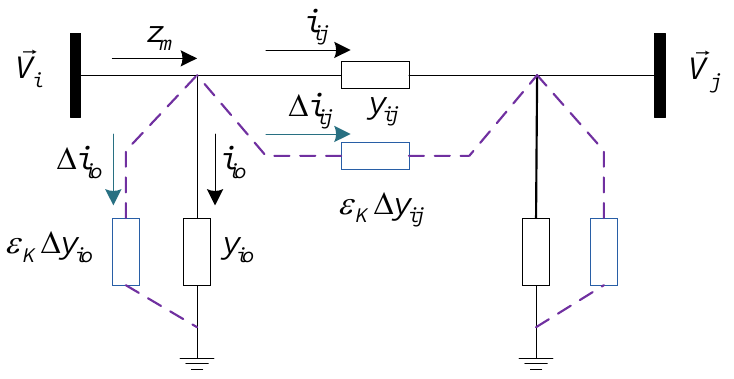
Figure 1. Equivalent circuit with adjustable admittances. In Figure 1, y ij and y io are constant admittances representing the nominal value, i ij and i io represent the currents following through y ij and y io , and ε K ∈ [ − 1, 1 ] refers to the adaptive parameters. According to the temperature variations, ∆ y ij and ∆ y io are safety allowance admittances approximated by the previous static data; ε K ∆ y ij and ε K ∆ y io are the adjusted terms; and ∆ i ij and ∆ i io represent the currents following through ε K ∆ y ij and ε K ∆ y io . Due to the transmission delay, ε K will be adaptive to be values within the range. ε K ∆ y ij and ε K ∆ y io will compensate for the small changes of line parameters with model uncertainty caused by large temperature variations and significant transmission delay. Accordingly, Equation (6) is obtained from Figure 1.